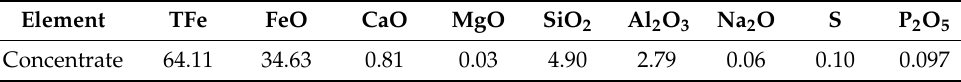
Table 4. Chemical compositions of the final ore iron concentrate (wt.%).